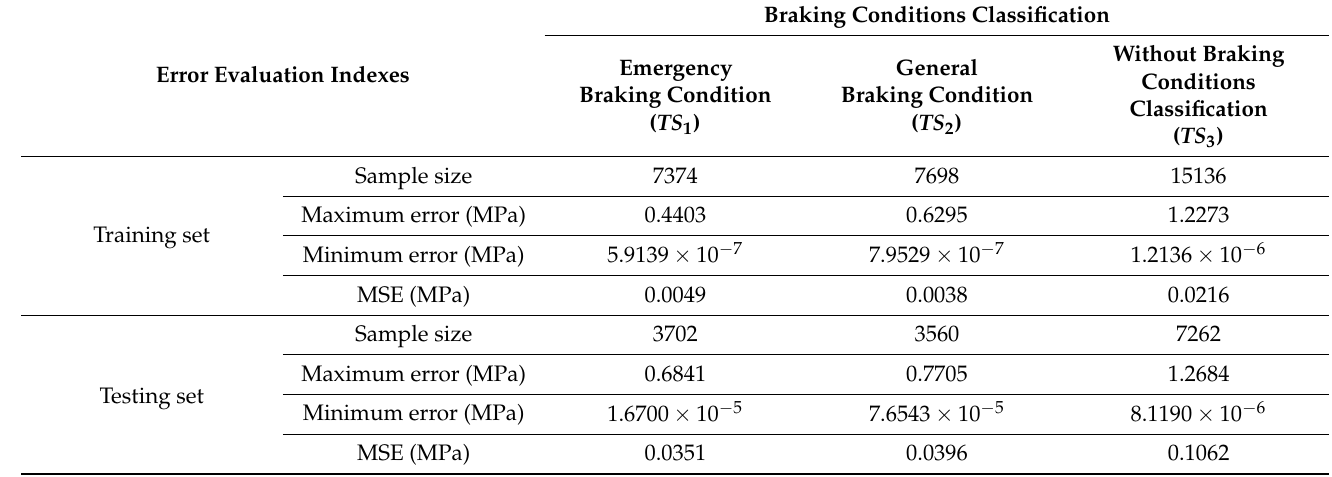
Table 4. Oil pressure recognition results for the training set and testing set.